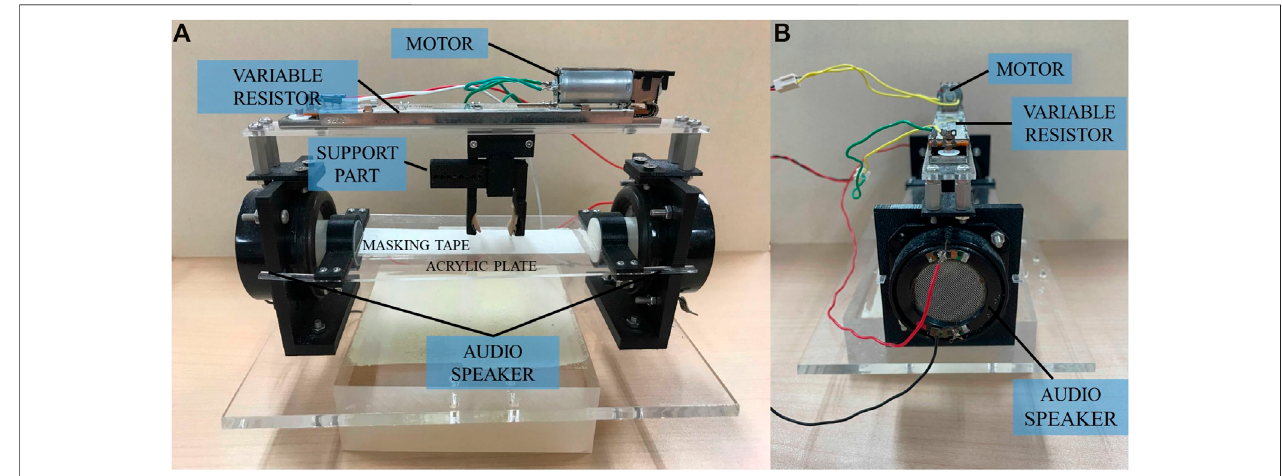
FIGURE 5 | Overview of the reproduction device. (A) Front-view; (B) Side-view.